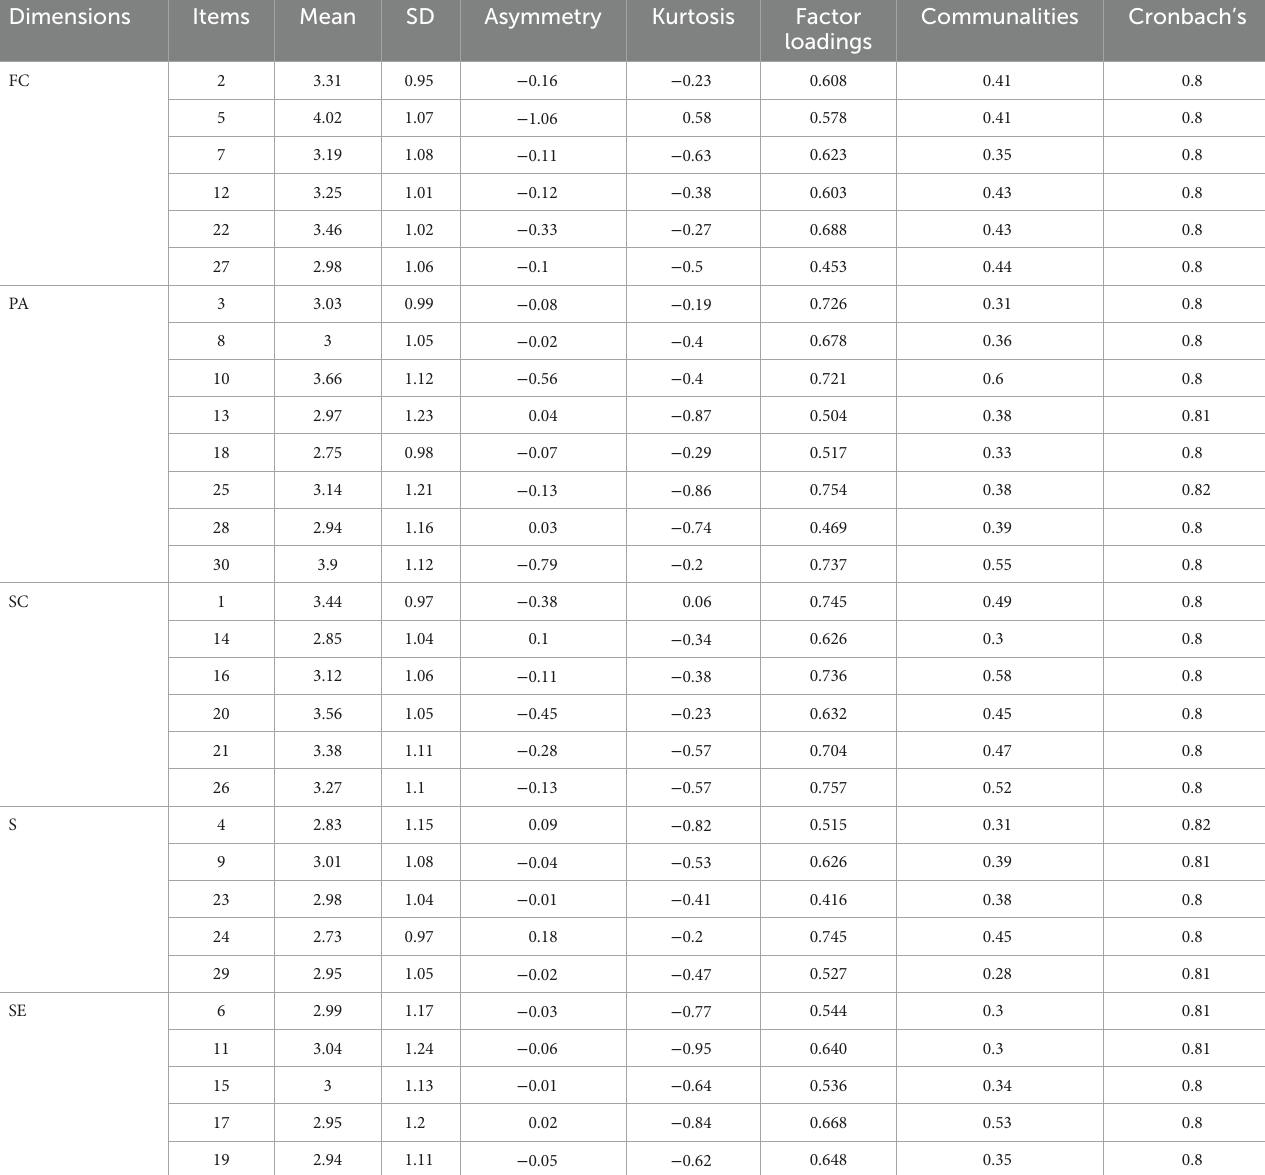
TABLE 3 Descriptive analysis (skewness and kurtosis) and validity and reliability values of the physical self-concept scale.